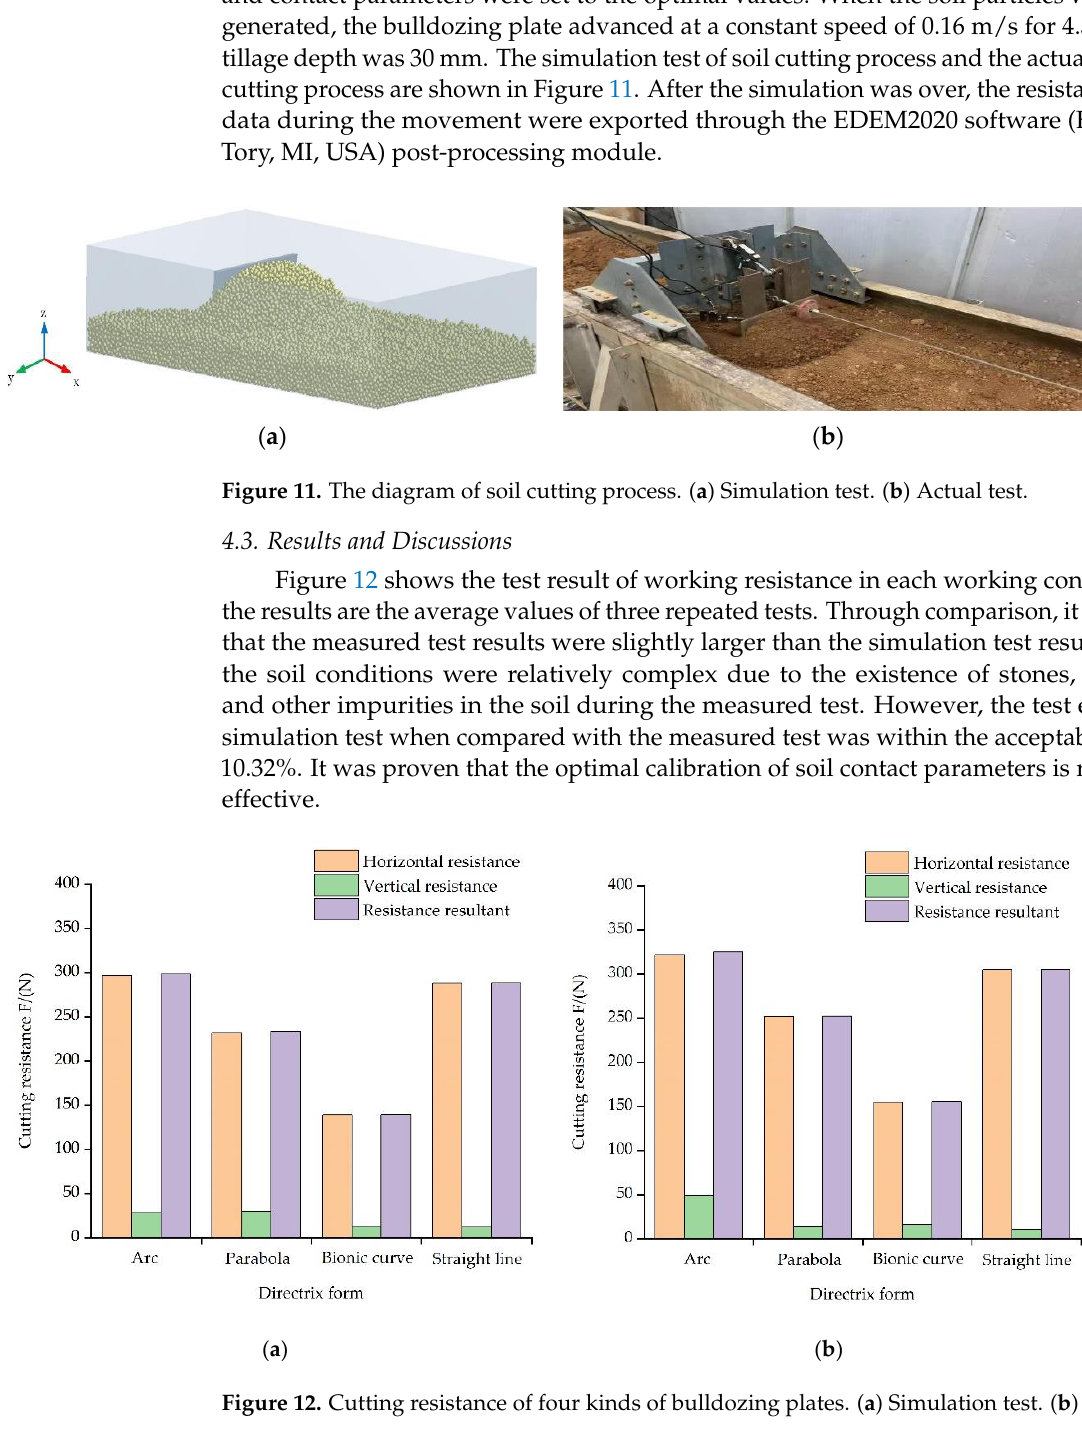
Figure 10. The t est system of soil cutting resistance . ( a ) Live photos of test work. ( b ) Schematic diagram of the force measuring device.